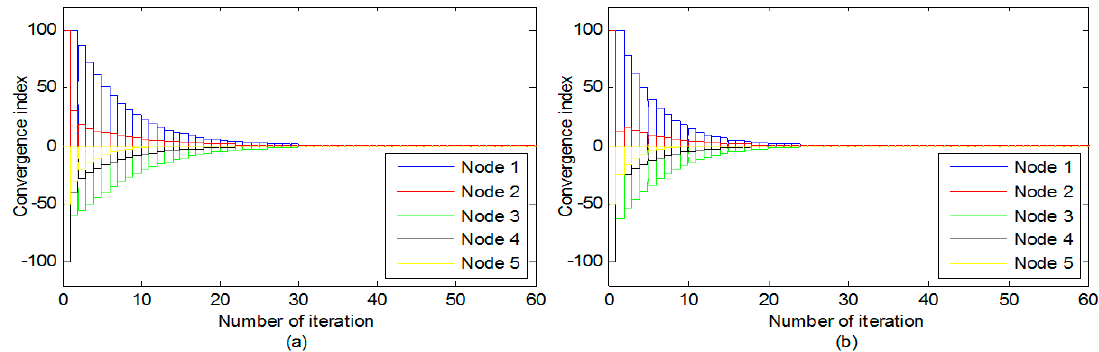
Figure 6. Comparison of converging speed of different methods: ( a ) uniform; ( b ) metropolis.